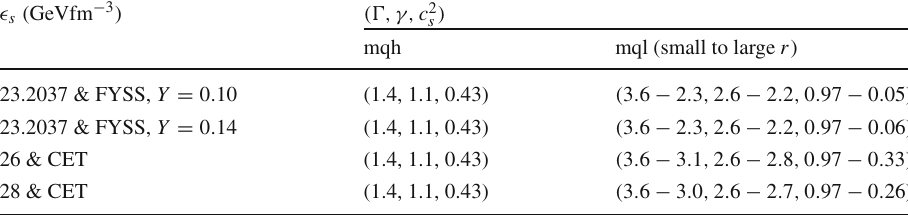
− 3 (cid:3) s (GeVfm